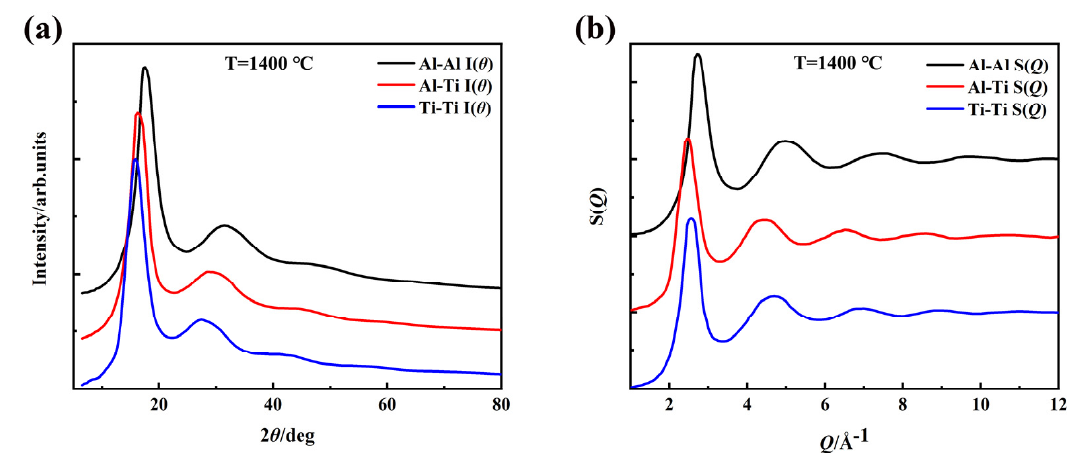
Figure 2. The Al 80 Ti 20 alloy melt. ( a ) HTXRD partial diffraction intensity S( Q ); ( b ) partial pair distribution function g( r ). Here, black, red, and blue lines represent the partial S( Q ) or g( r ) of Al–Al, Al–Ti, and Ti–Ti, respectively.